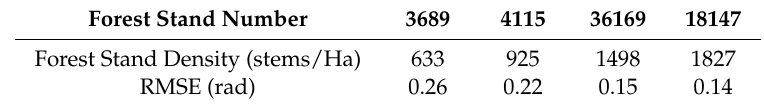
Table 3. Assessment of the ground phase estimation errors for different density.